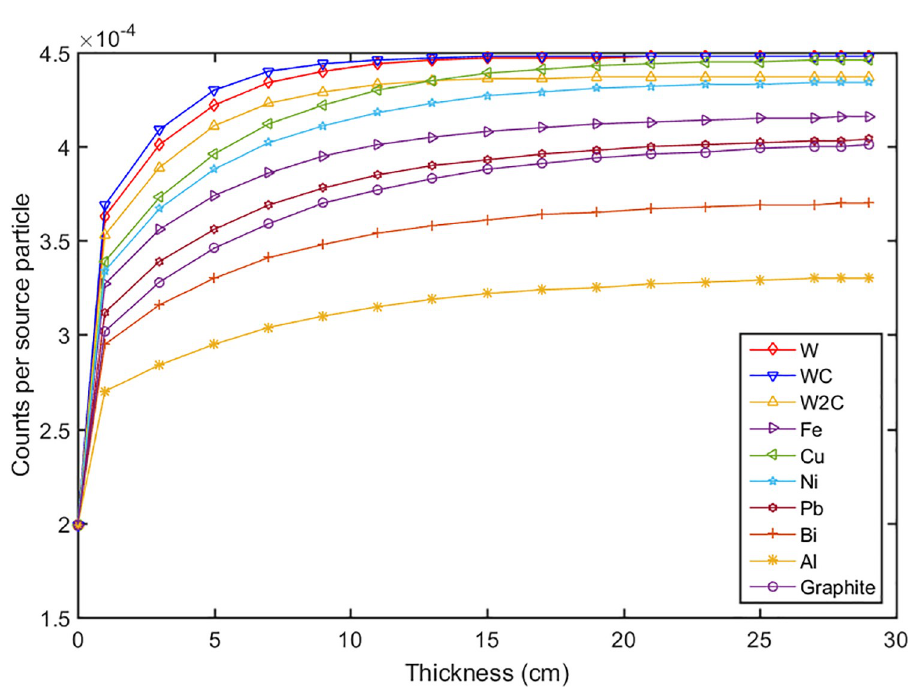
Fig 3. The neutron flux versus the thicknesses of t2 with different materials.